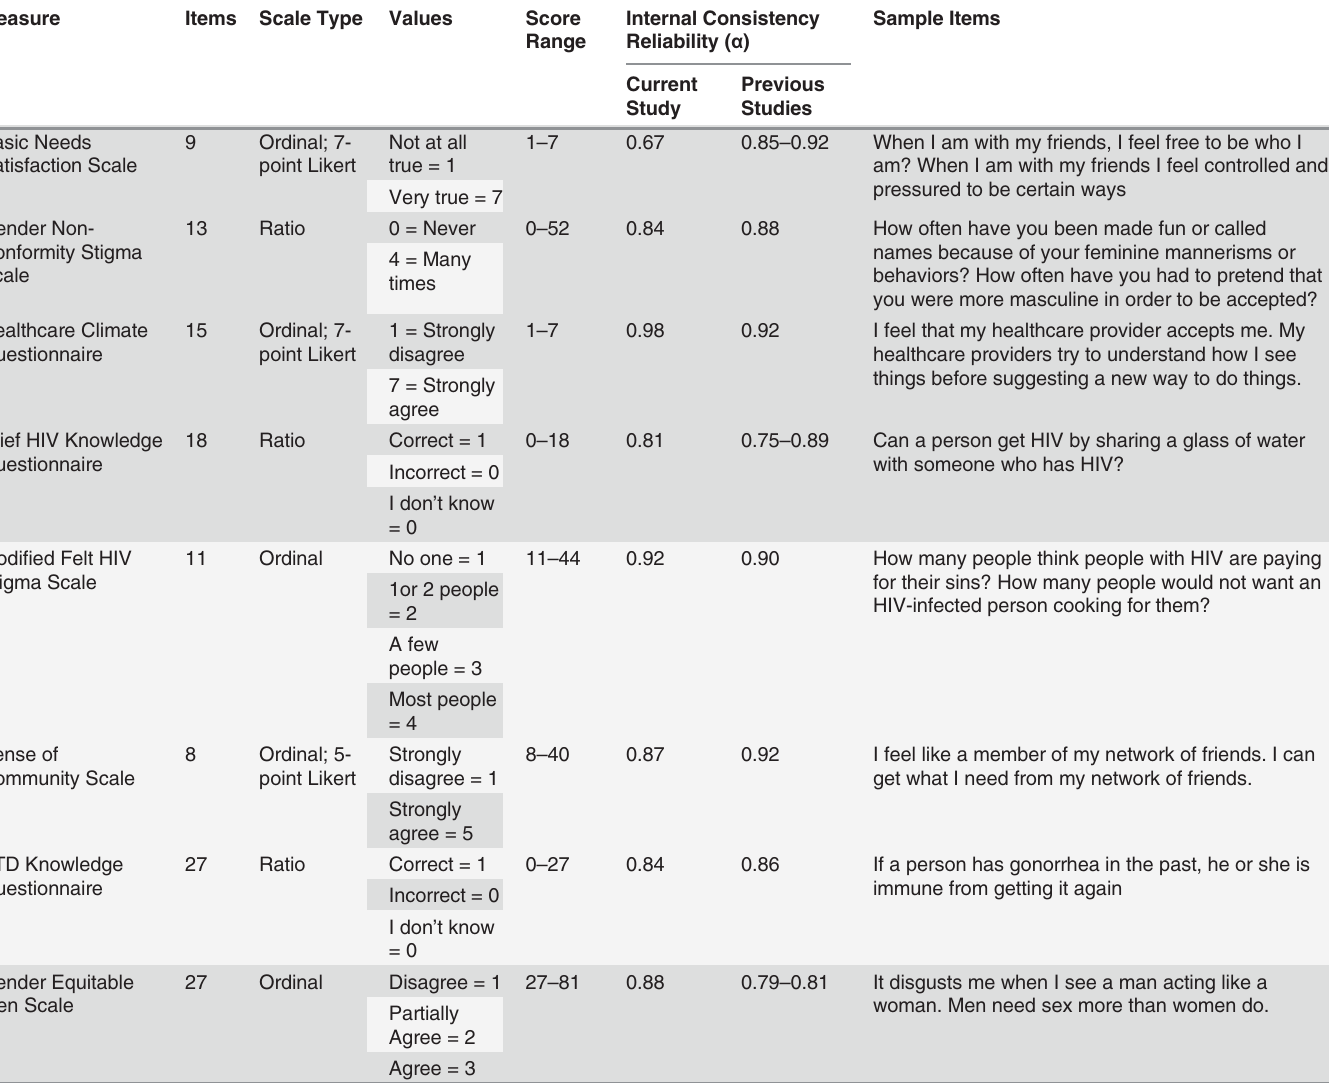
Table 1. Summary Description of Scales Measuring Psychosocial